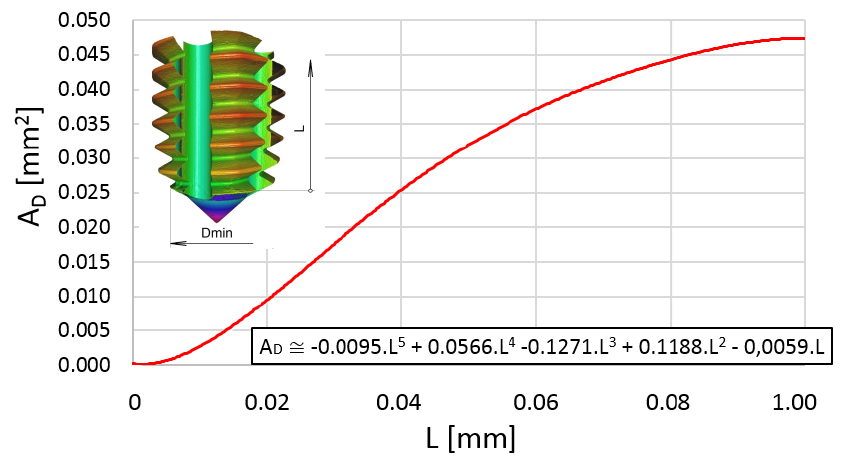
Figure 5. Application of polymers: the soap ( a ), the concentrate ( b ), and the diluted solution ( c ). The mathematical analysis of the cross-section of the material to be formed into thread confirmed a polynomial curve of the fifth order according to its length—Figure 6.